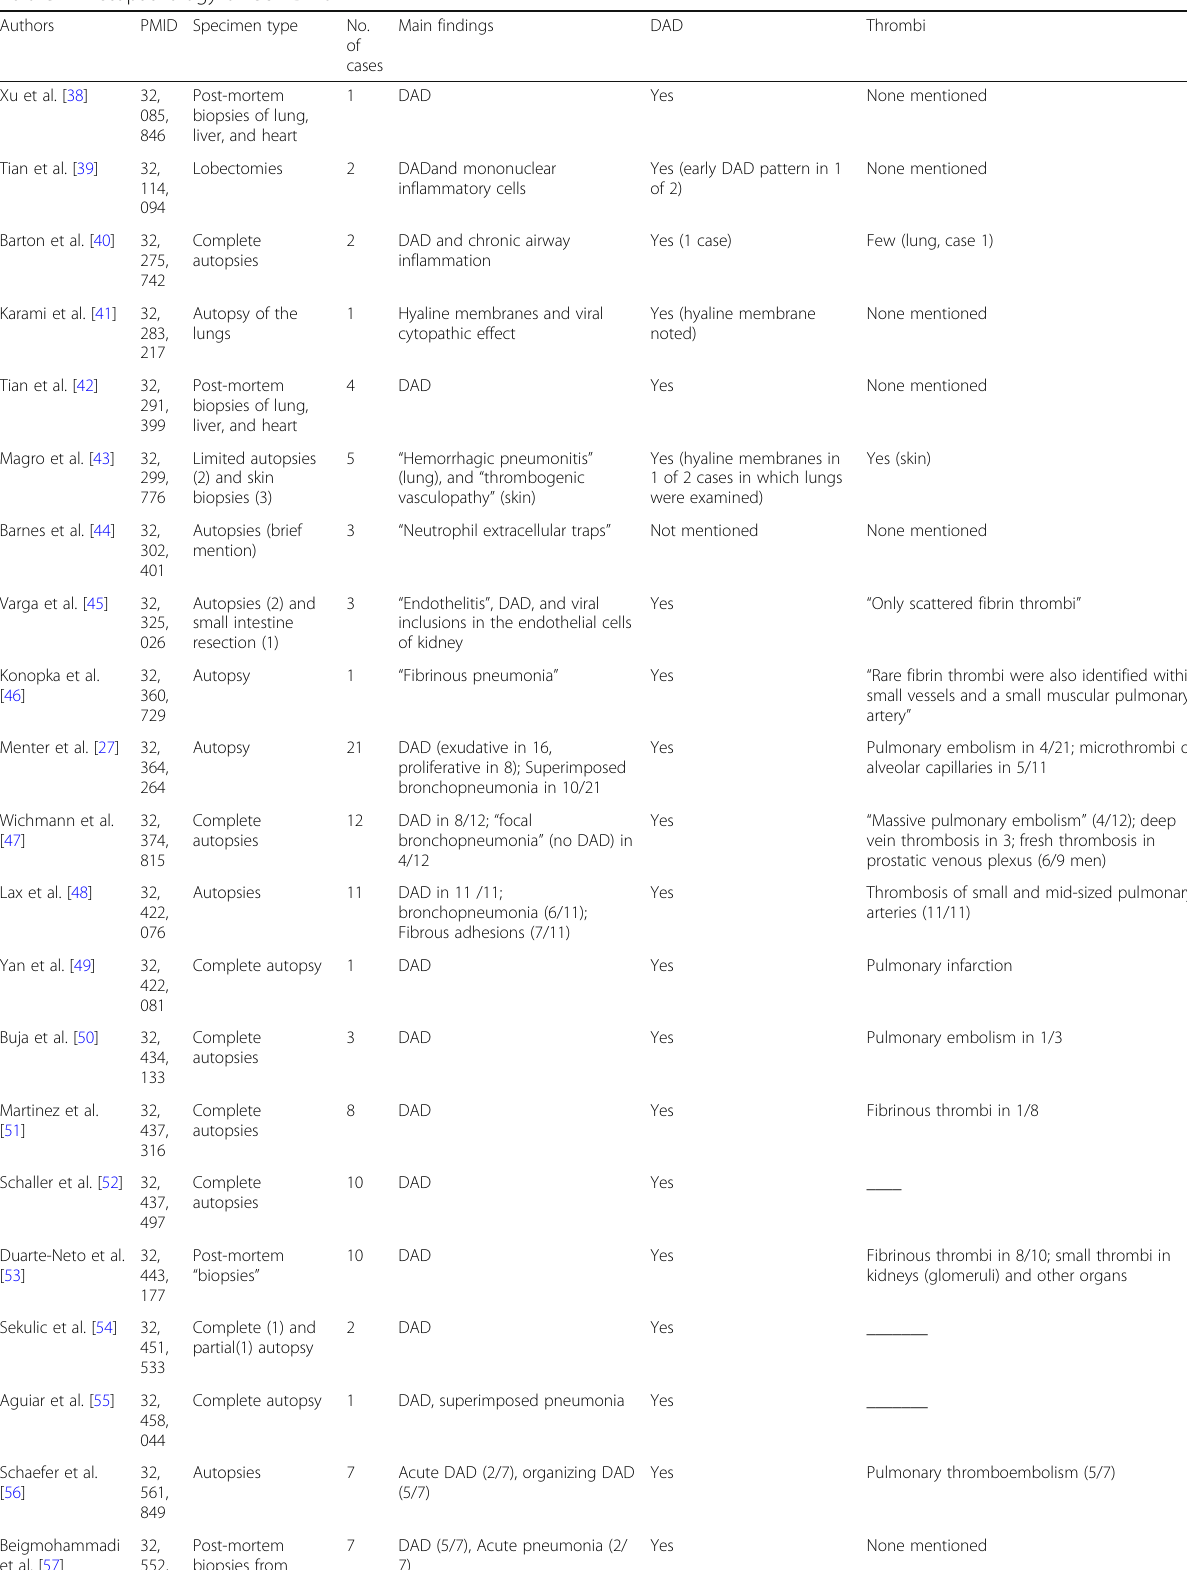
Table 2 Histopathology of COVID-19